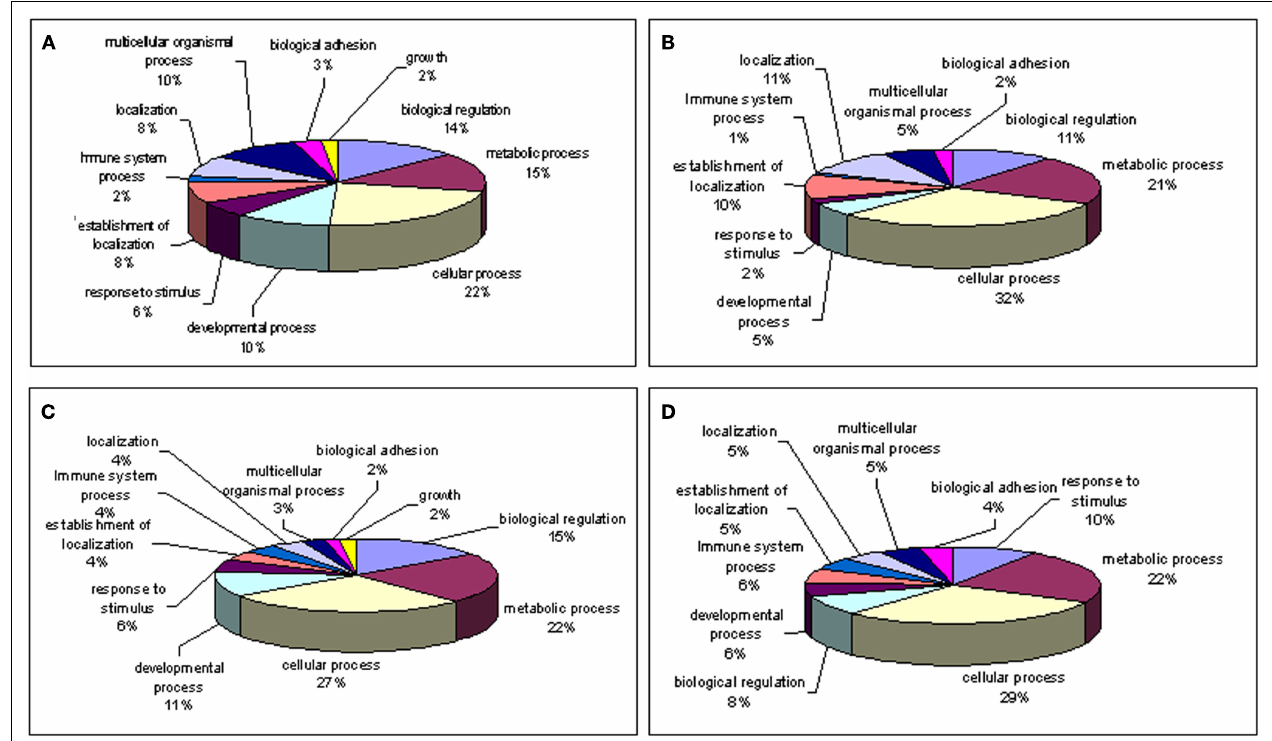
with older peripheral retina. Note that genes involved with “growth” are only shown in young macula and peripheral retina but missing in older macula and